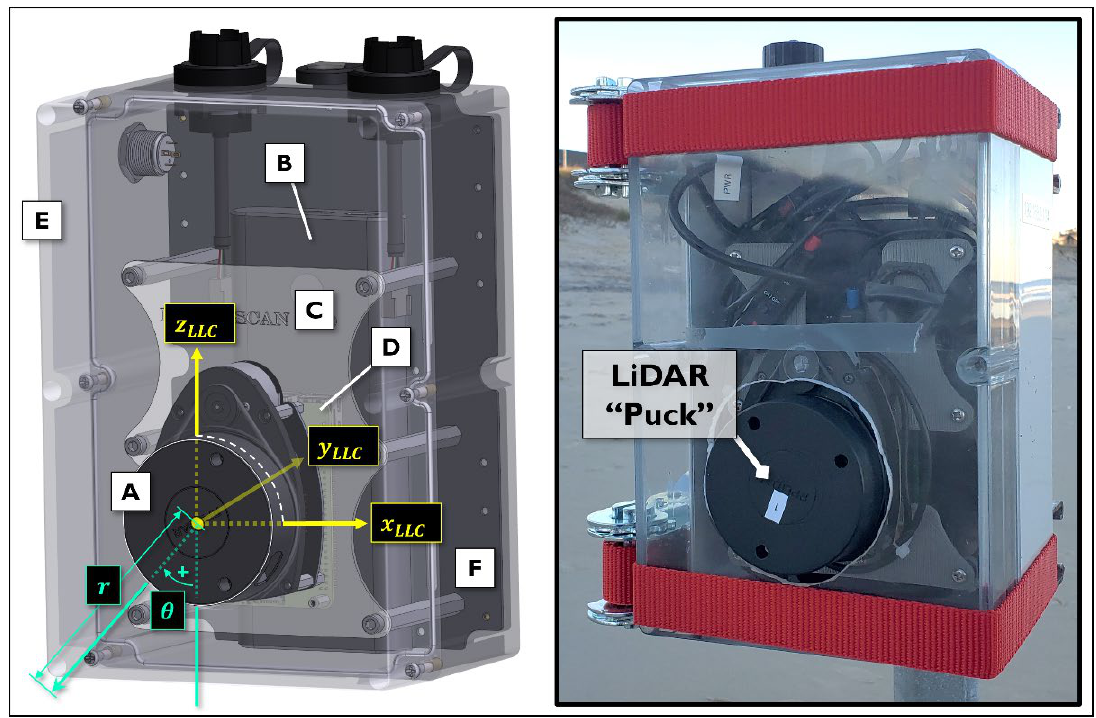
Figure 1. (left) 3D Computer Aided Design (CAD) model and (right) physical model, strapped to a pole on the beach, of the Line-scanning, Low-Cost (LLC) LiDAR system. The local “LLC” cartesian and polar coordinate systems are drawn on the CAD model. Major components include ( A ) Slamtec RPLiDAR A1M8 (R5) 360° laser range scanner; ( B ) Anker PowerCore+ 26800mAh PD USB battery pack; ( C ) 3D printed (PLA), custom-designed mounting bracket; ( D ) Raspberry Pi 3B+ single board computer; ( E ) Polycase enclosure (Part # WC-41); ( F ) Polycase aluminum baseplate (Part # WX-42).